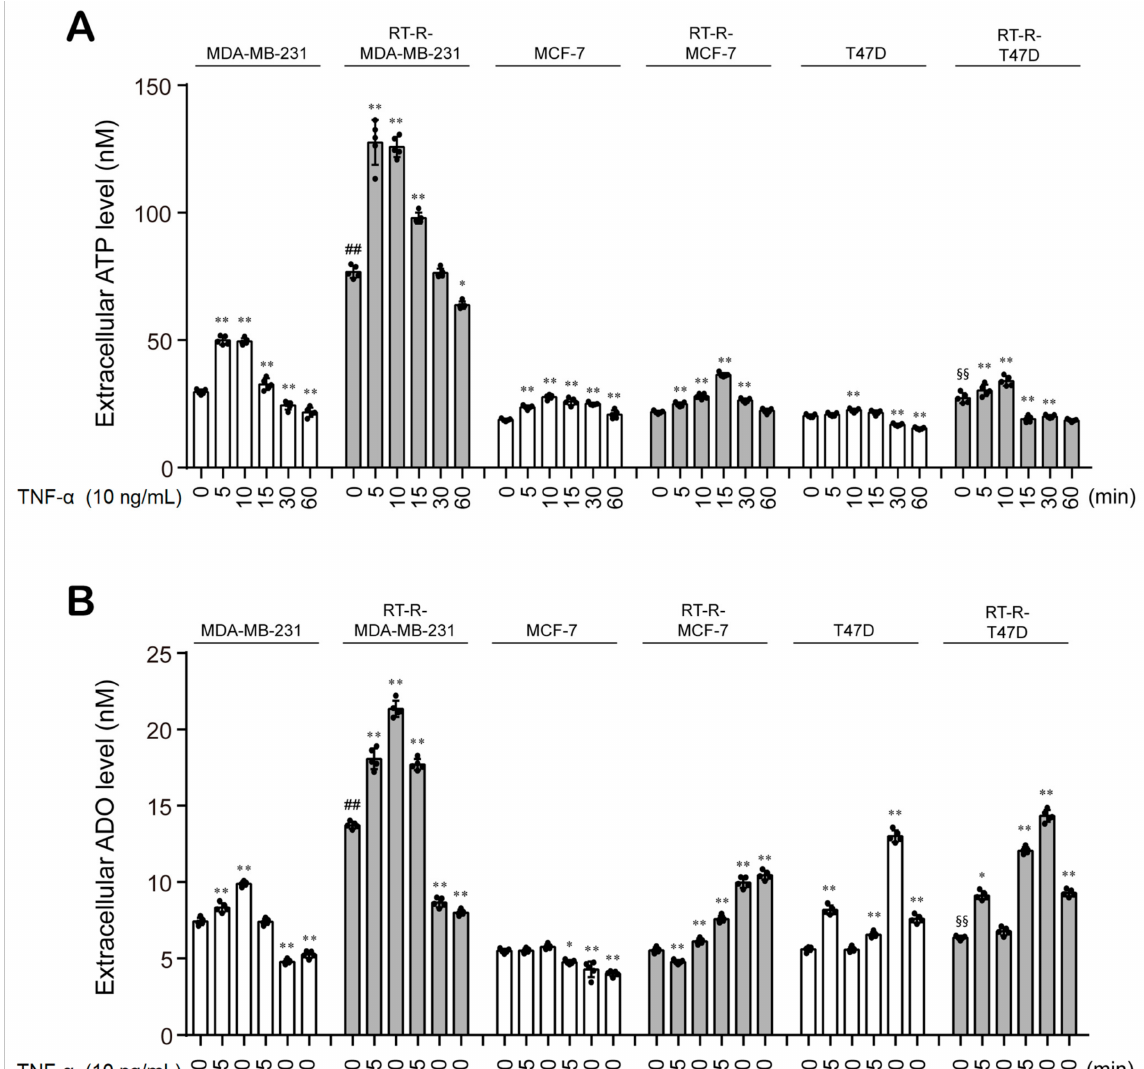
Figure 2. The extracellular levels of ATP and ADO are increased in the MDA-MB-231, a TNBC cell line, when compared to any other non-TNBC cells, and are more enhanced in RT-R-MDA-MB-231 cells. ( A , B ) BC cells (MDA-MB-231, MCF7, T47D) and their RT-R-BC cells (RT-R-MDA-MB-231, RT-R-MCF7, RT-R-T47D) were treated with TNF- α for the indicated time, and the extracellular levels of ATP ( A ) and ADO ( B ) were measured using the ATP assay system kit and ADO ELISA Kit, respectively, as described in Section 2. The values represent the means ± SD of 5 independent experiments. * p < 0.05, ** p < 0.01 compared to the control of each cell line; ## p < 0.01 compared to the control of MDA-MB-231; §§ p < 0.01 compared to the control of